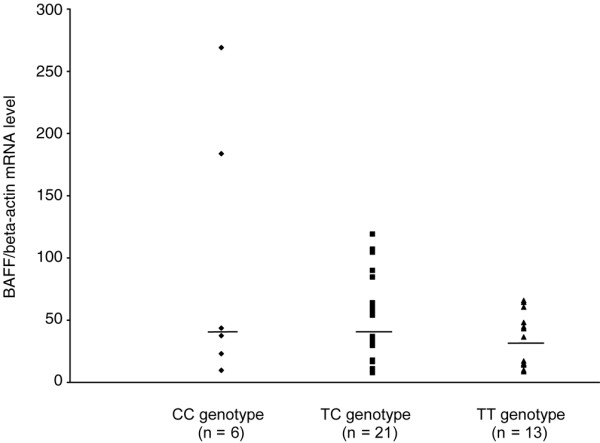
Association between BAFF -871 T/C polymorphism and BAFF mRNAin 40 patients with pSS. Bars represent median levels of BAFF mRNA. BAFF = B-cell-activating factor; pSS, primary Sjögren's syndrome.